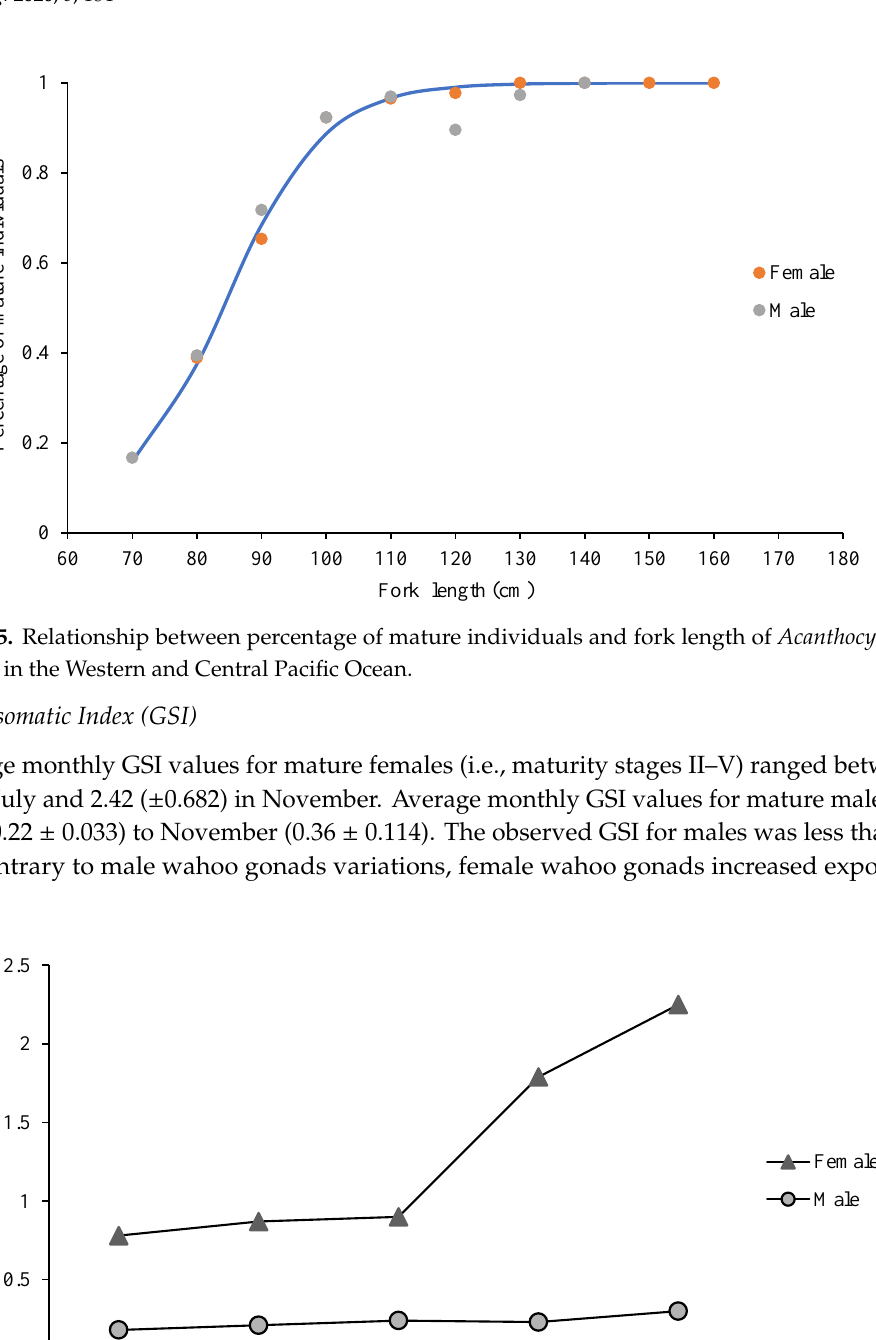
7 of 14 Figure 4. Monthly number of wahoo specimens grouped per maturity stages (two for male specimens: first two rows; five for females: last five rows) in the Western and Central Pacific Ocean. Numbers in the table represent monthly catches per maturity stage. A logistic regression estimated the fork lengths at 50% sexual maturity (FL 50% ) for female and male wahoo as 84 cm and 83 cm, respectively (Figure 5). Among all individuals that reached sexual maturity for female wahoo, more than 47.6% of them were those from the maturity class Ⅳ (mature- active specimens); more than 89% of male wahoo specimens were mature (stage II). Female ： P =